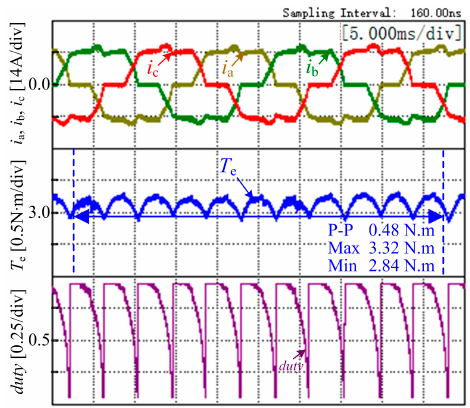
Figure 12. Experimental waveforms with the proposed strategy under the rated load at 600 r/min.